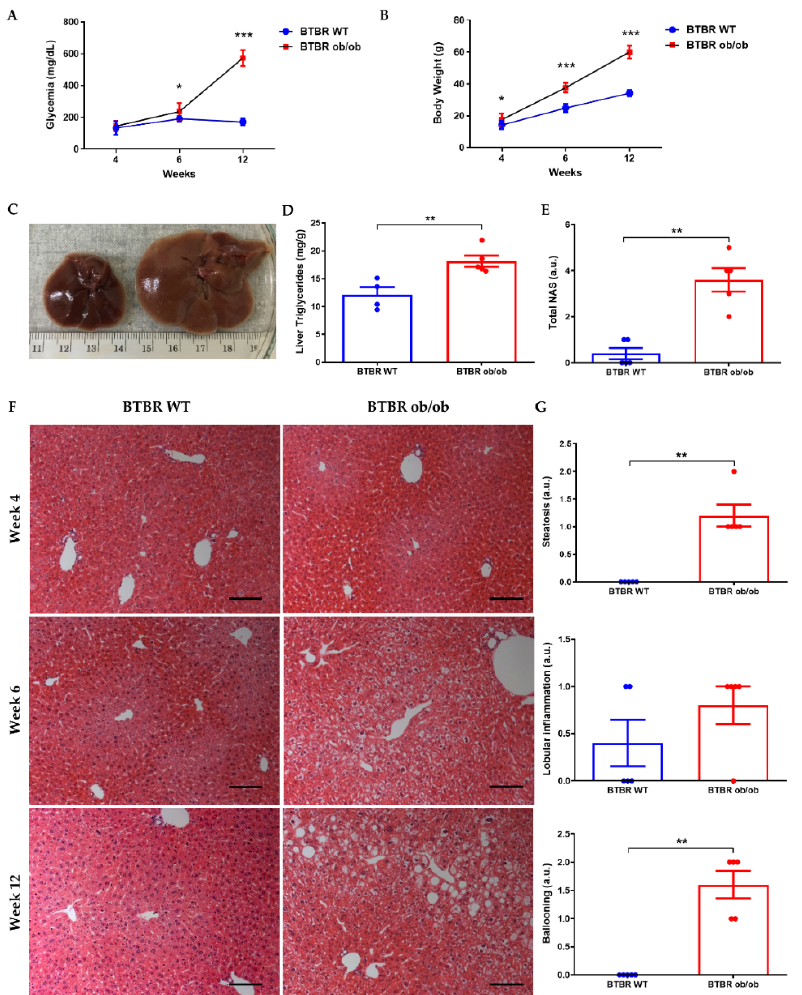
Figure 1 . Progression of liver steatosis from weeks 4 to 12. Non-fasting glycemia ( A ) and body weight ( B ) of BTBR WT and BTBR ob/ob mice at 4, 6 and 12 weeks. ( C ) Macroscopic photograph of liver at 12 weeks in BTBR WT (left) and BTBR ob/ob mice (right). ( D ) Measurement of liver TGs at 12 weeks. ( E ) NAFLD activity score (NAS) assessment at 12 weeks ( F ) Representative H-E images of livers of BTBR WT (left) and BTBR ob/ob mice (right) showing steatosis progression (magnification 100 × ) from 4–12 weeks. ( G ) Semi-quantitative determination of steatosis, lobular inflammation and hepatocytes ballooning in livers of mice at 12 weeks. Data are shown as scatter dot plots and mean ± SEM of each group ( n = 5–6 mice/group); * p < 0.05, ** p < 0.01, *** p < 0.001 vs. BTBR